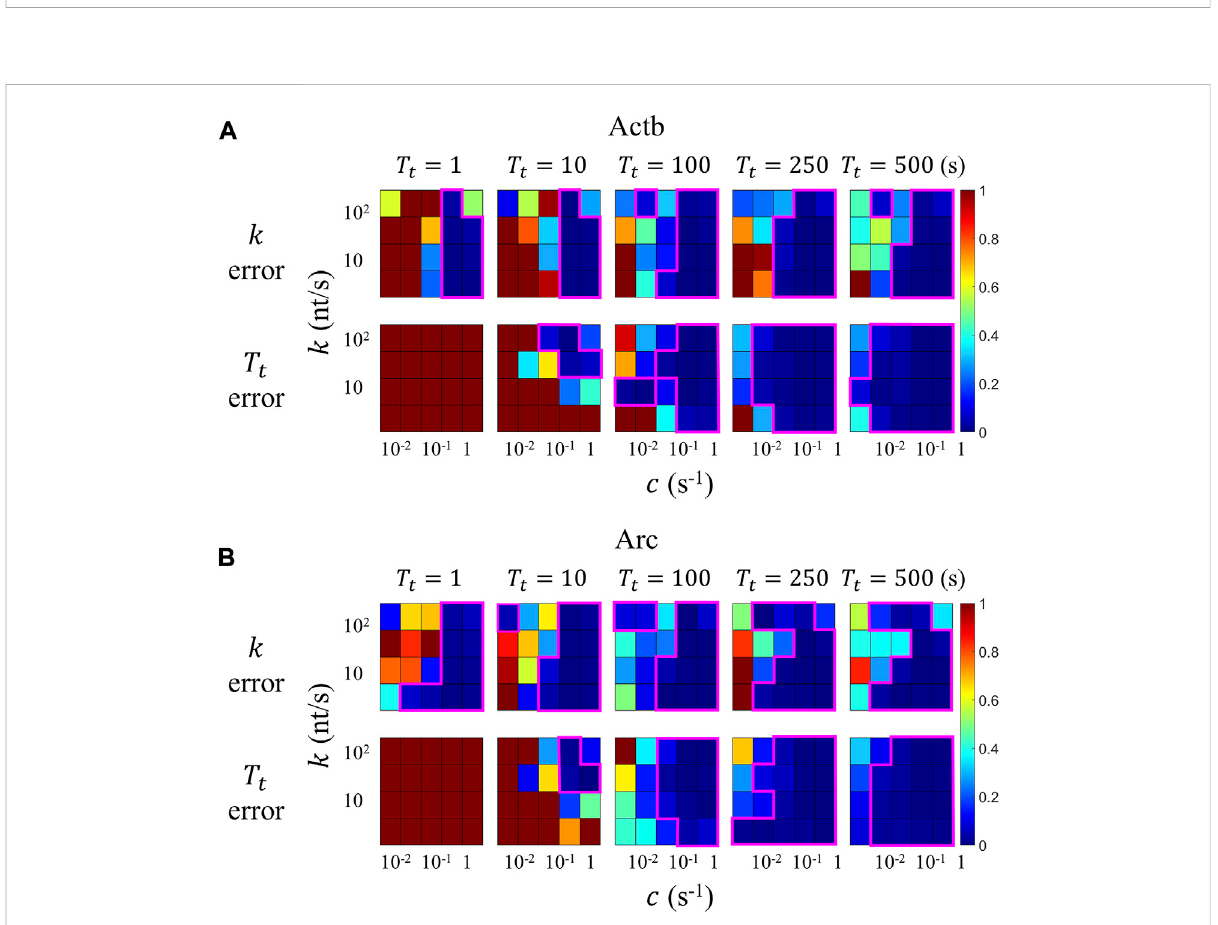
FIGURE 8 Assessment of errors in the time-resolved transcription analysis by using simulations. Simulation input parameters are initiation rate c , elongation rate k , and termination time T t . (A,B) Mean errors of k and T t obtained by fi tting the results from 100 simulation runs are shown in color maps for Actb (A) and Arc (B) . All error values over 1 are displayed in dark red color. Regions with a mean error under 10% are denoted with magenta